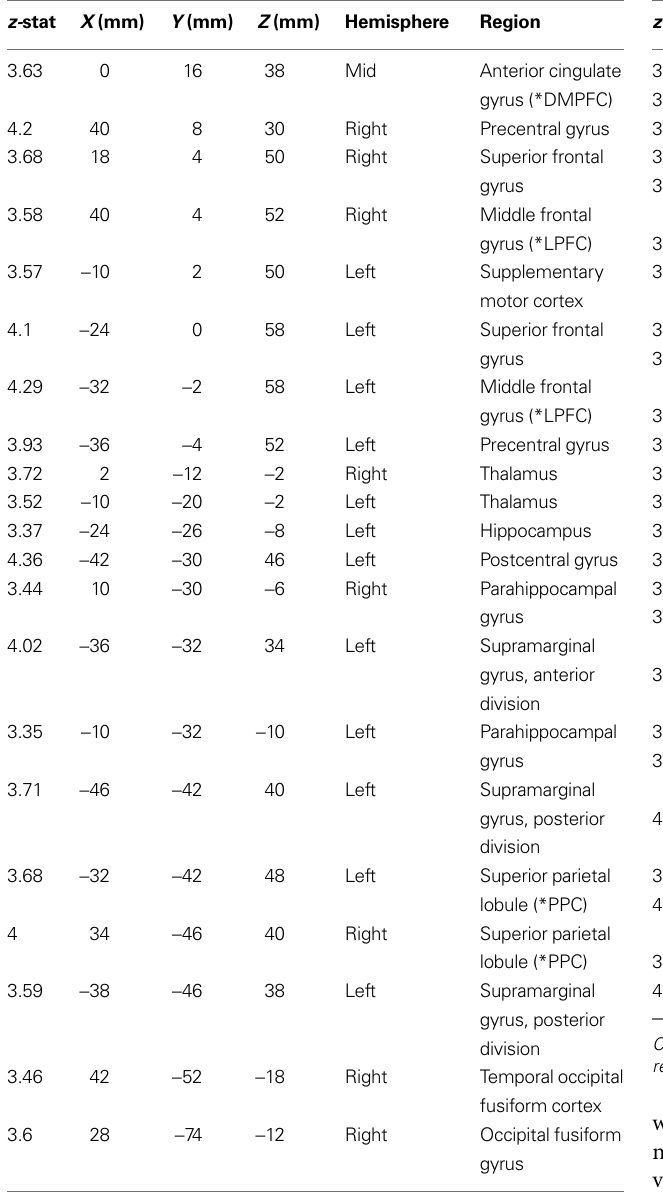
Table 1 | Regions exhibiting main effects of Reversal Changes . Table 2 | Regions exhibiting main effects of Effect Changes .